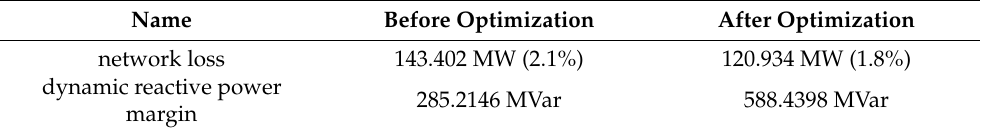
Table 8. Comparison of network loss and dynamic reactive power margin before and after optimization.